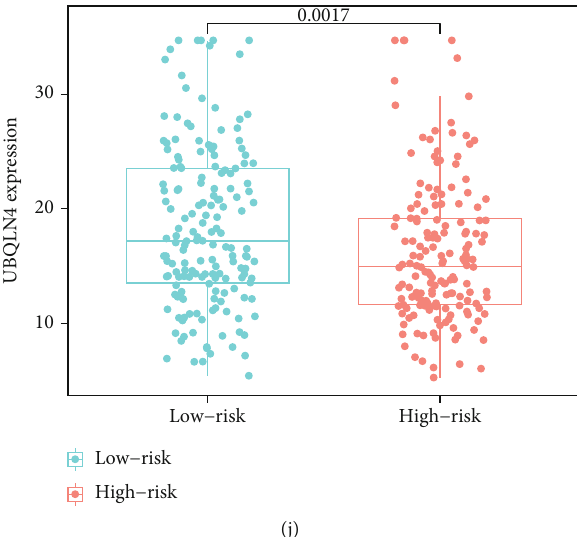
Figure 3: Patient characteristics in the high- and low-risk groups in the testing and whole sets. (a, f) Survival distribution of high- and low- risk patients. (b, g) ROC curves predicting 1-, 3-, and 5-year survival rates. (c, h) Expression of the 8 miRNAs changed with increasing risk score. Comparisons of somatic mutation count and UBQLN4 expression in the high- and low-risk groups in the (d, e) testing and (i, j) whole TCGA